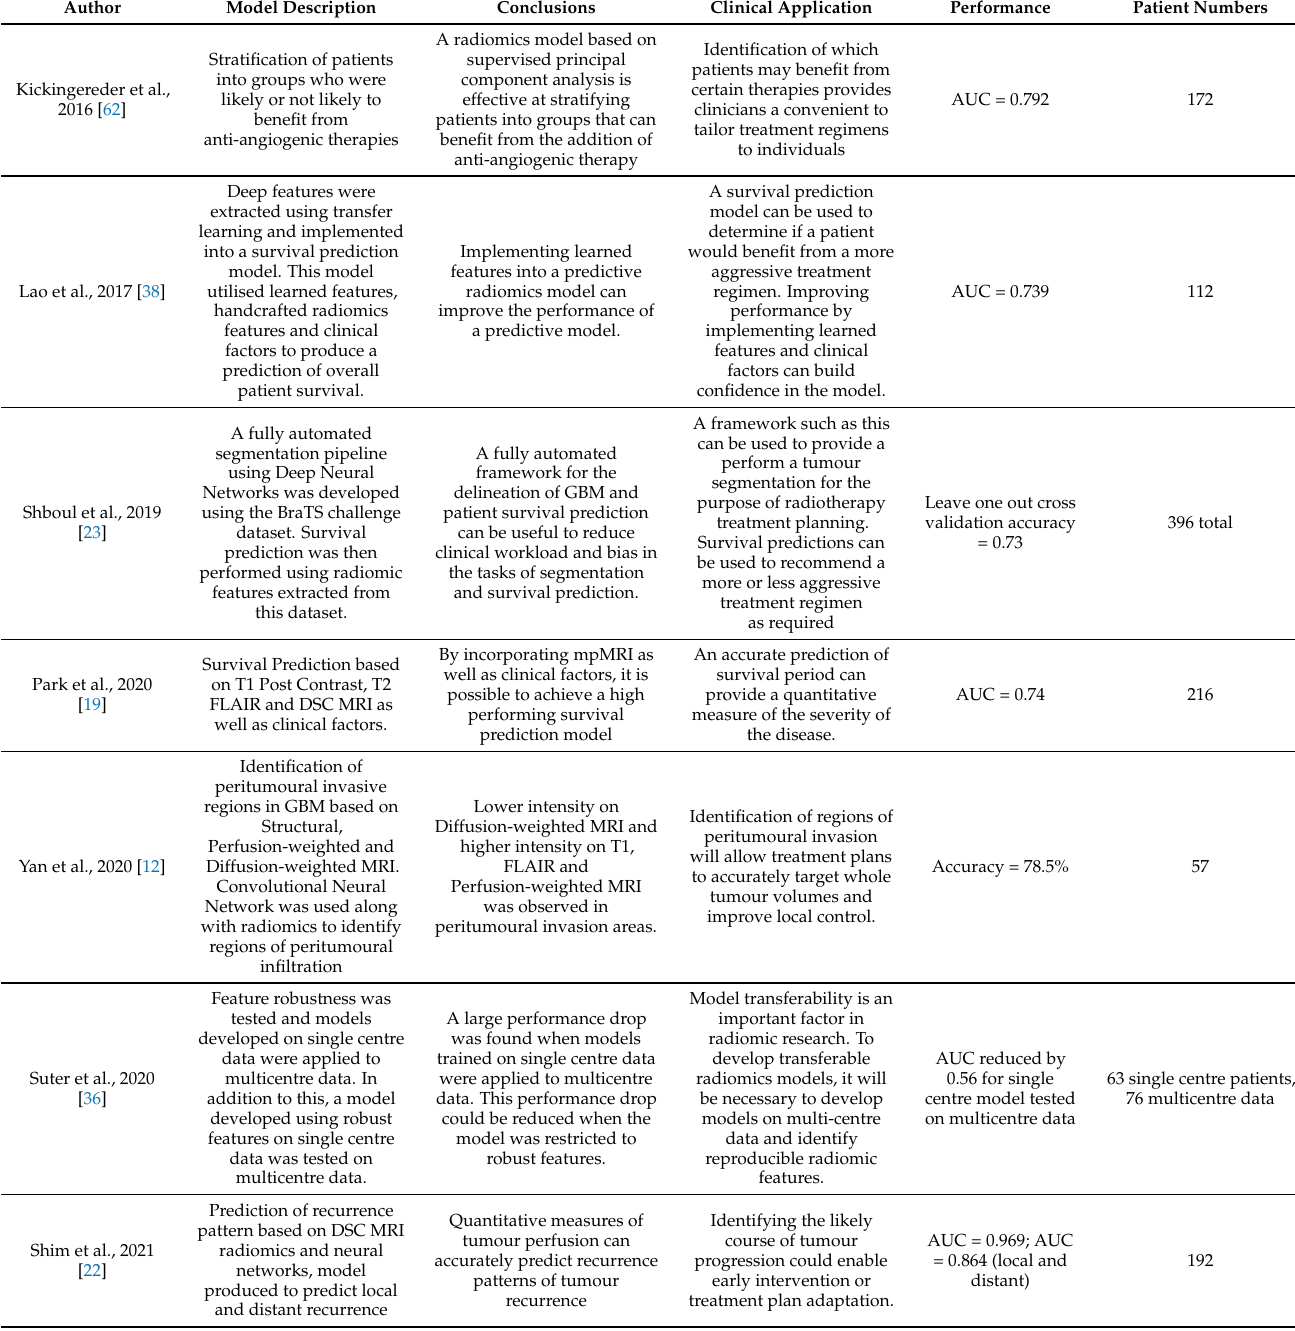
Table 2. A selection of modern radiomics models for predicting clinical and biological factors in